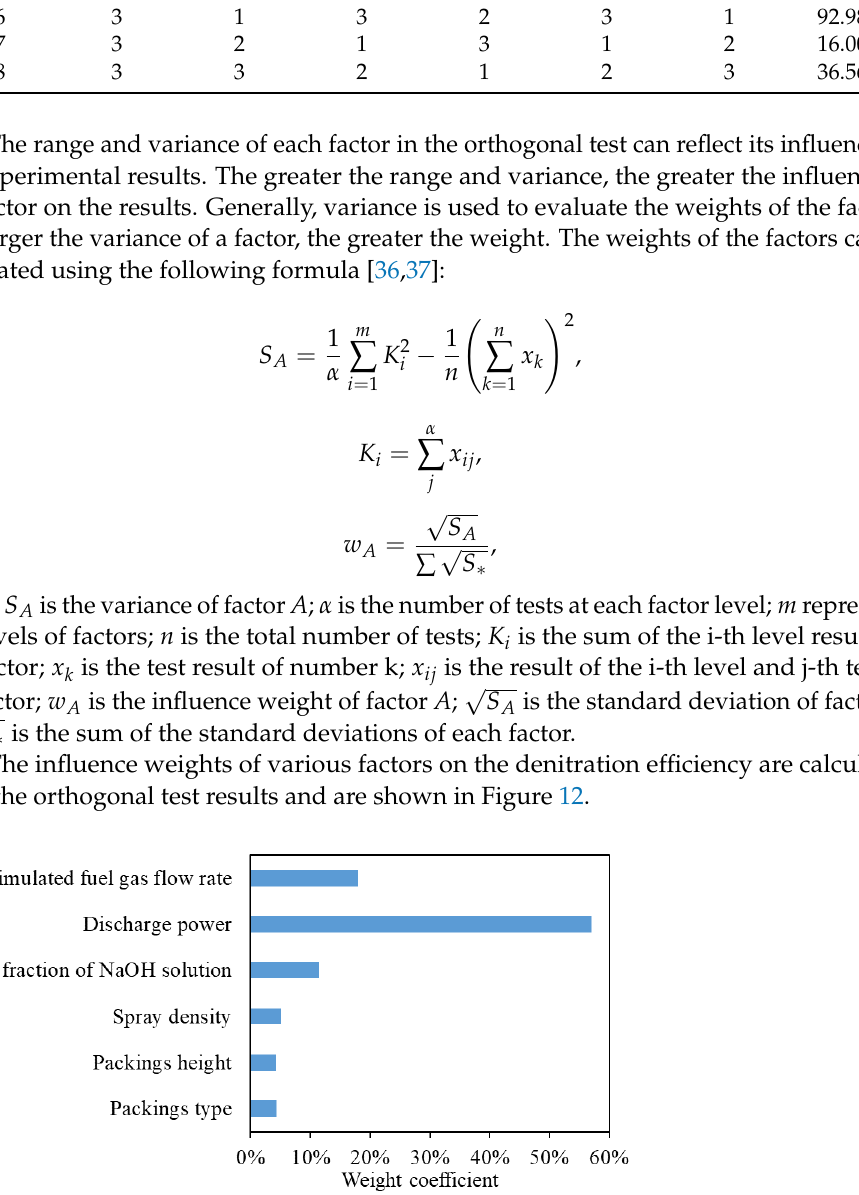
Figure 12. Influence weight of each factor on the denitration efficiency.